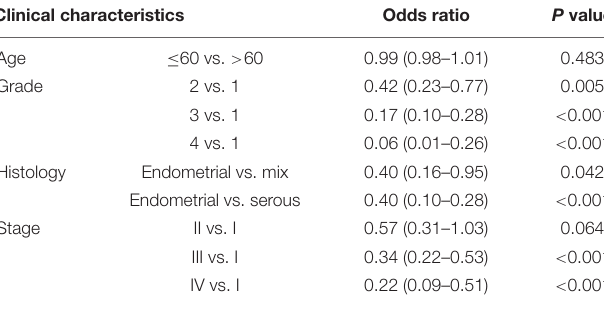
level of RILPL2 by comparing EC tissues with normal